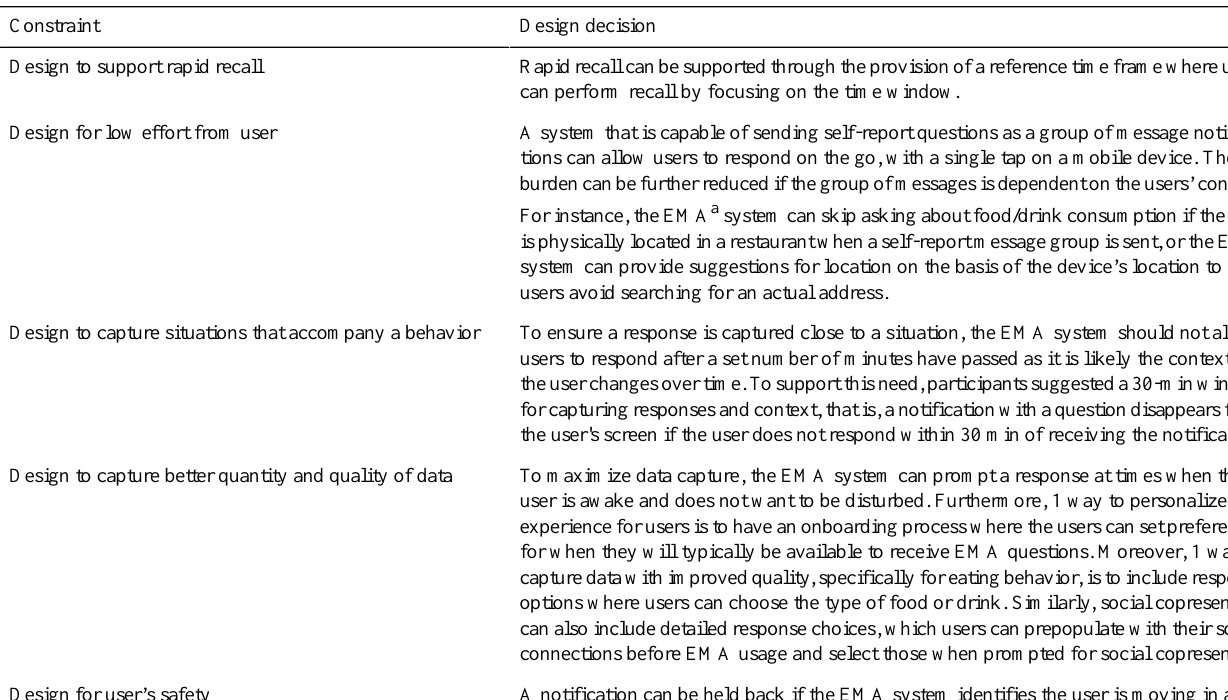
Table 2. Design decisions on the basis of constraints.